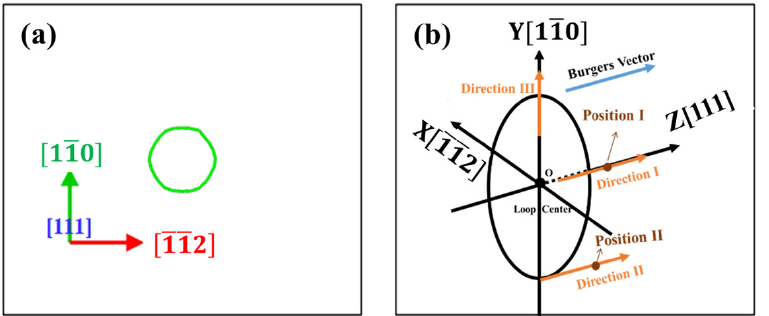
Figure 1. ( a ) The sketch of the simulation box. The green ring represents the 1/2[111] dislocation loop. ( b ) The schematic picture of the configuration of a 1/2[111] dislocation loop and a vacancy-type defect. The vacancy-type defect is placed at the position that is along three different directions. Direction I is through the center of the dislocation loop and parallel to the Burgers vector. Position I is along the Direction I and has a distance of 15 Å to the habit plane (HP). Direction II is along the edge of the dislocation loop and parallel to the Burgers vector. Position II is along the Direction II and has the distance of 15 Å to the HP. Direction III is through the center of the dislocation loop on the HP.